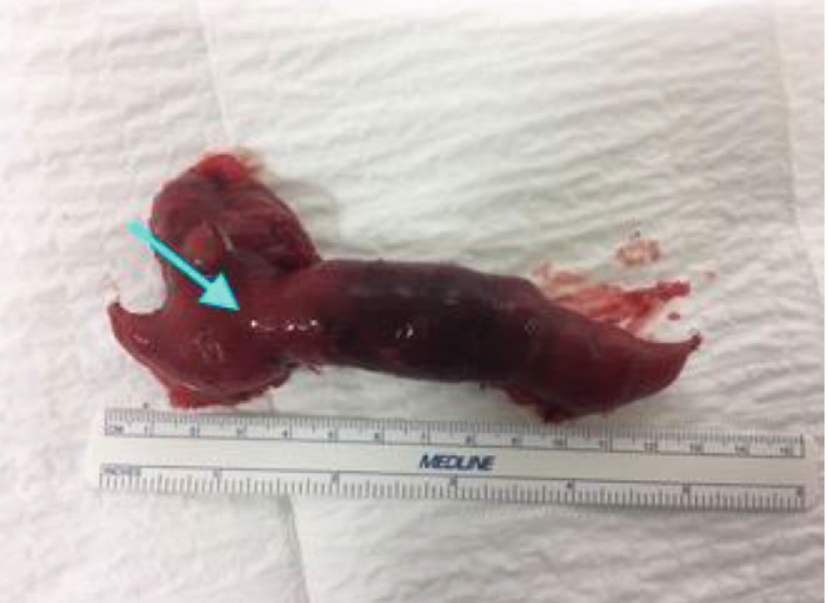
Figure 7: Meckel ’ s diverticulum specimen case